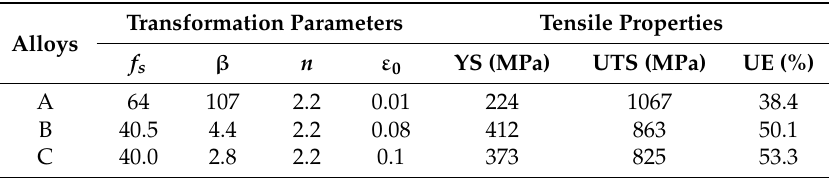
Figure 2. ( a ) Volume fraction of transformed α ’-martensite as a function of inelastic strain; ( b ) a plot showing the deformation mode parameter n = 2.2 regardless of nitrogen content. Table 2. Transformation parameters and tensile properties.